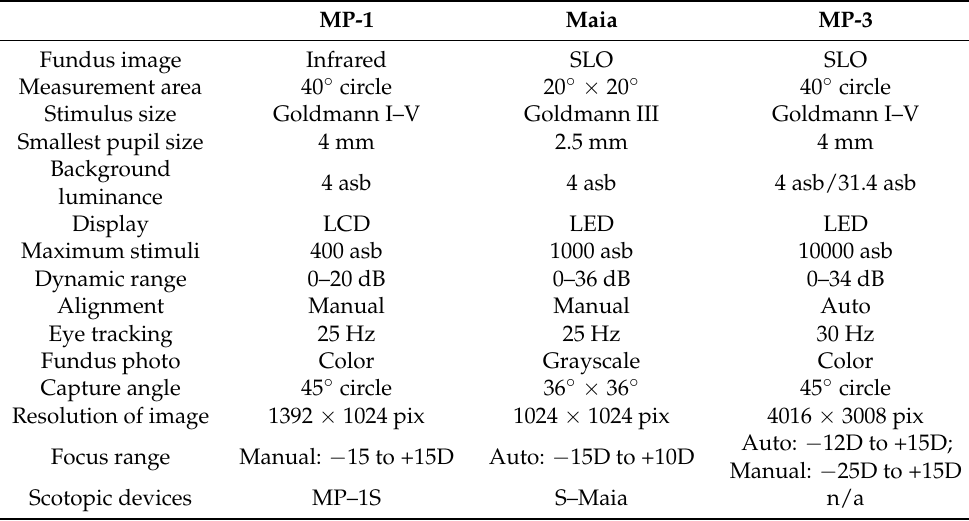
Table 1. Comparison of different types of fundus